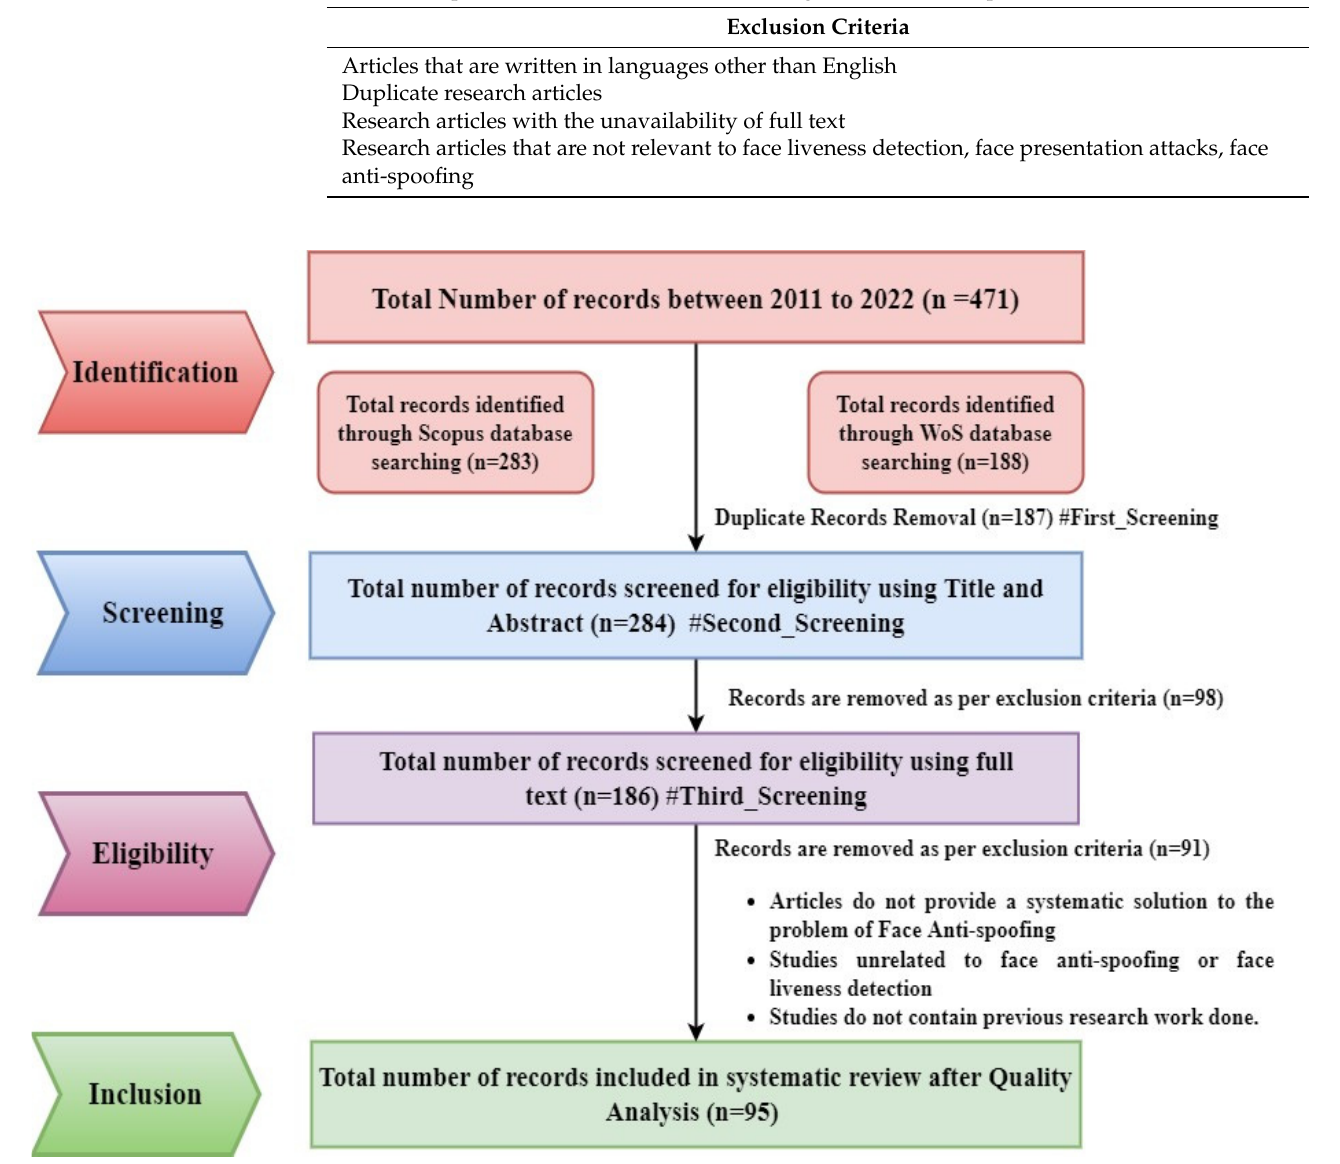
Figure 3. Flowchart identifies and selects studies for systematic review using the PRISMA approach [38].